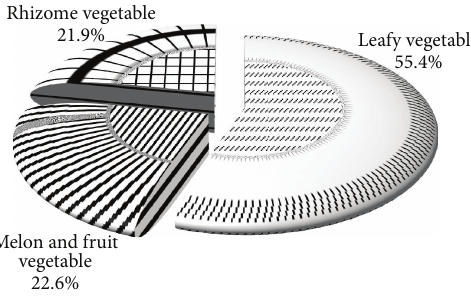
Figure 1: Percentage distribution of PAH16 in different groups of vegetables.